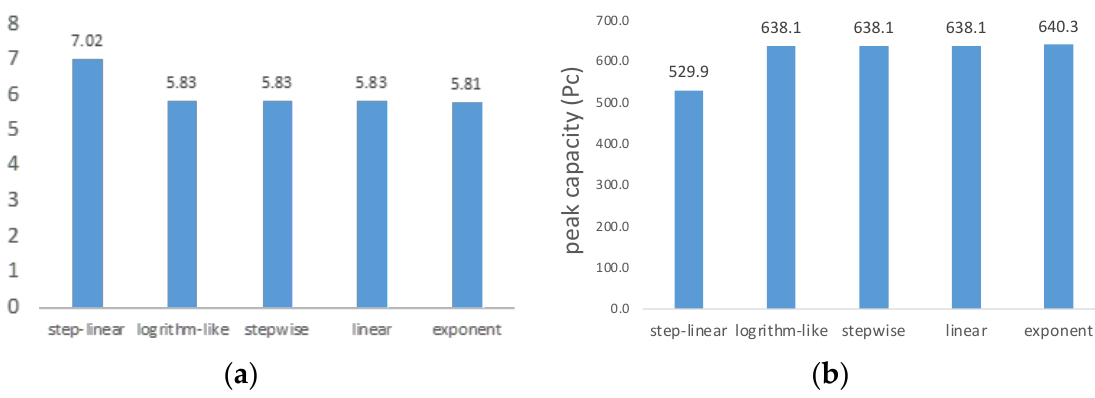
Figure 5. Comparison of ( a ) median FWHM and ( b ) peptide peak capacity among five gradient types. The median FWHM was calculated based on all peptides (with a minimum intensity of 2500) using MaxQuant (version 2.0.3.1). Peptide peak capacity was calculated by dividing the run time by the median FWHM. Ion chromatograms are shown in Figures S1 – S12.